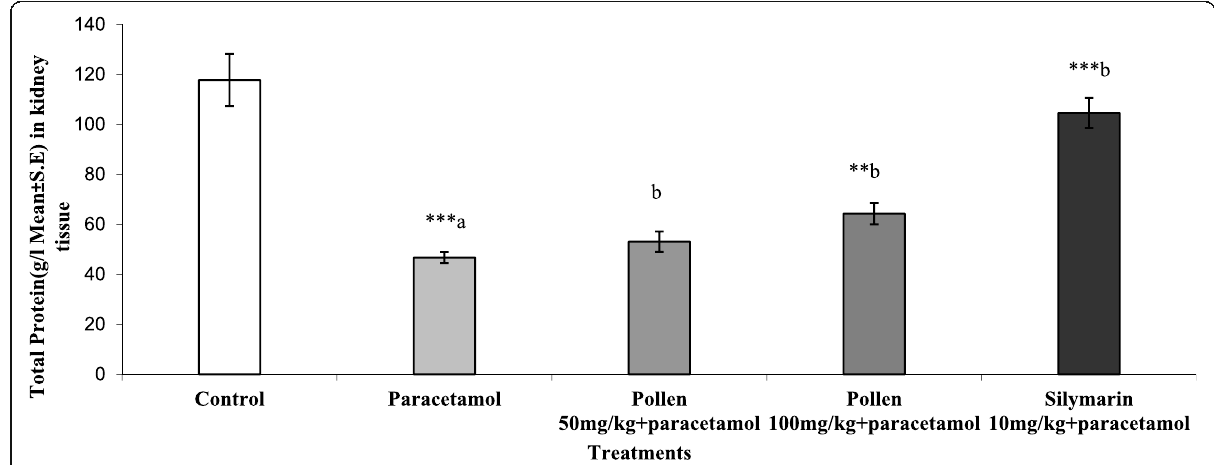
Fig. 6 Kidney tissue Total Protein levels. Total Protein levels in rats intoxicated with APAP alone and treatment with DPP and Silymarin. All values represent mean ± SEM. ** p < 0.01, *** p < 0.001; ANOVA, followed by Dunnett ’ s multiple comparison test. a As compared with control group. b As compared with APAP